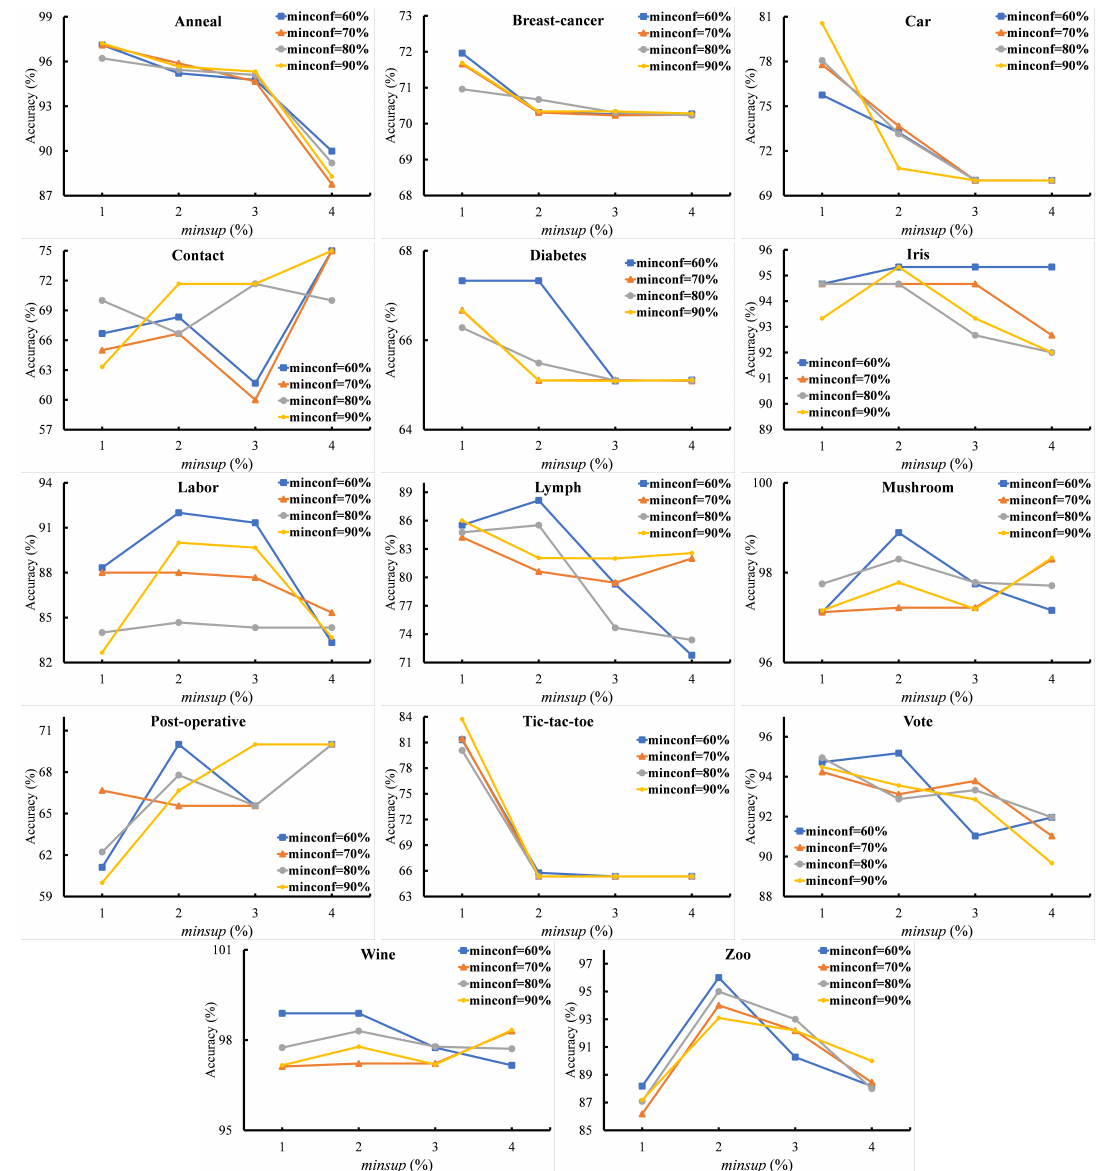
Figure 1. Accuracy rates in various minsup and mincof on all